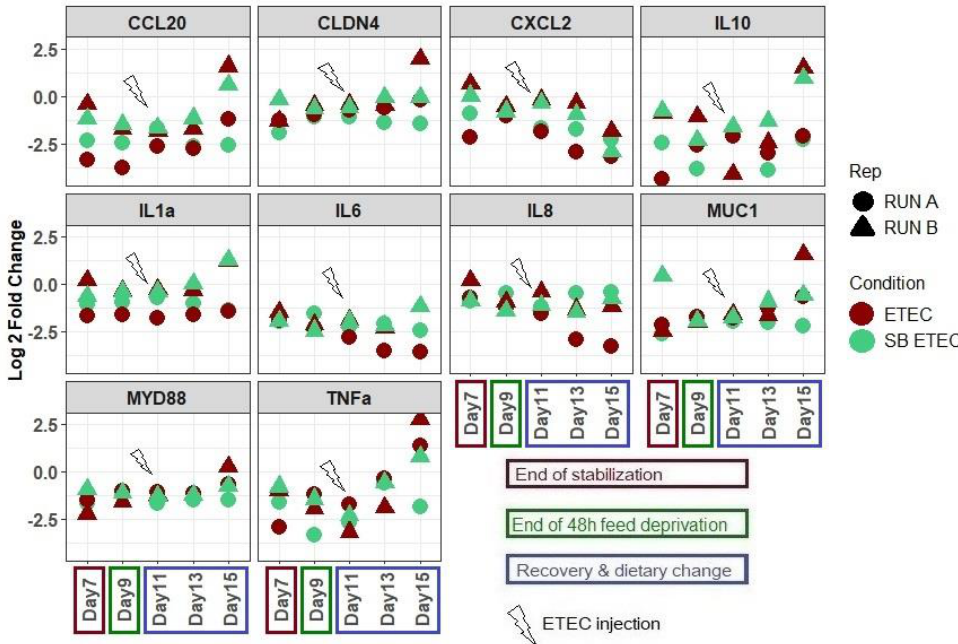
Figure 6. Log 2 fold changes of IPI-2I cells gene expression when incubated with bead medium supernatants collected from the MPigut-IVM under ETEC and SBETEC conditions. Fold changes are calculated compared to the control condition where IPI-2I cells were incubated with their usual glutamine and FCS complemented DMEM medium. Each value is an average of two technical replicates.